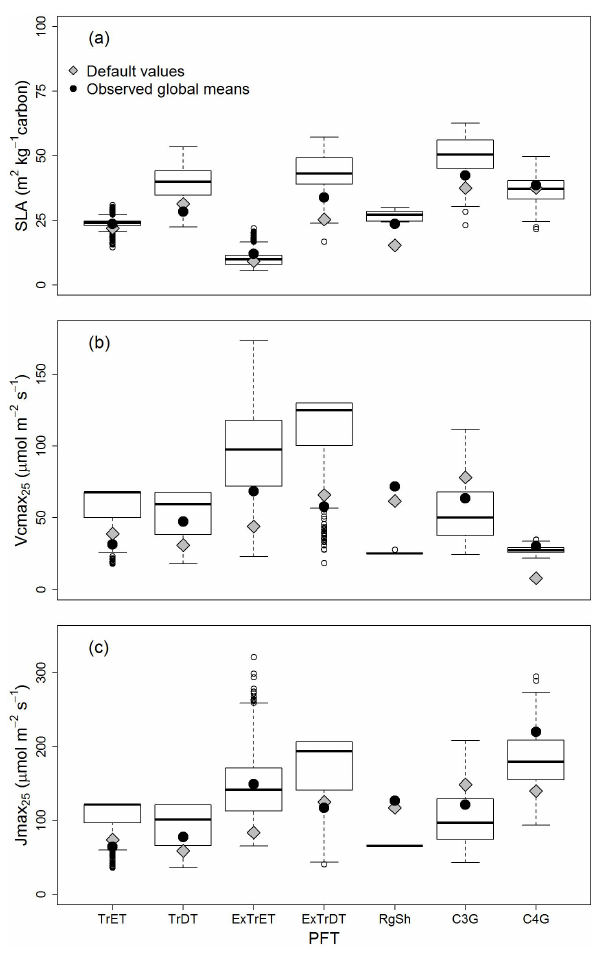
Fig. 2. Simulated trait ranges of the dominant PFTs of each grid cell in the variable traits simulation: (a) SLA (m 2 kg − 1 carbon), (b) Vcmax 25 (µmolm − 2 s − 1 ), (c) Jmax 25 (µmolm − 2 s − 1 ). For C4 grasses, PEPcase CO 2 specificity (PEP, in mmolm − 2 s − 1 ) instead of Jmax 25 is modeled. Box plots and symbols as in Fig. 1. PFTs as in Fig. 1 but without cold/deciduous shrubs (DSh), because this PFT was never dominant. Observed global means are added again for illustrative purposes. Note that direct comparison with simulated data is not appropriate here as the range of climatic conditions do not overlap for observed and simulated trait